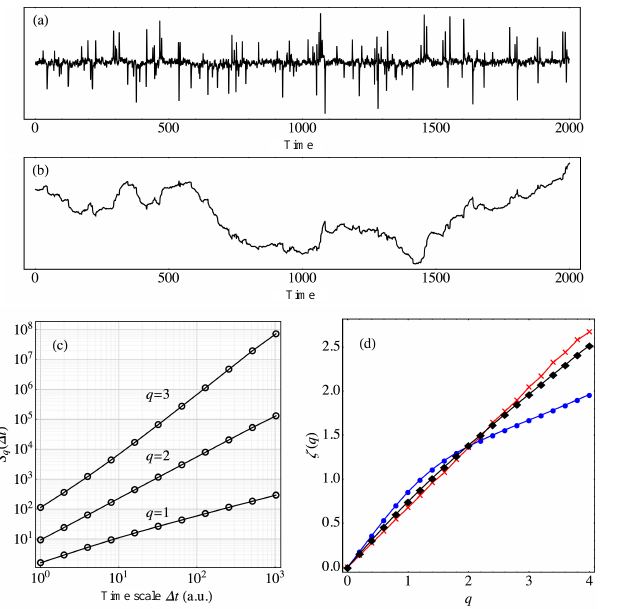
Figure 5. (a) The increments of a jump-diffusion process shown in (b) . This is a non-Gaussian independent noise process. (b) A re- alisation of a jump-diffusion process, and the cumulative sum of the signal in (a) . This process is the sum of a Brownian motion and a Poisson jump process as described in Appendix B. The jump distribution is Gaussian with a standard deviation that is 10 times greater than the standard deviation of the increments of the Brown- ian motion. (c) S q ( (cid:49)t for q = 1 , 2 , 3 for the jump-diffusion process as computed from a large ensemble of realisations of the process. (d) Scaling function ζ ( q ) estimated from structure functions like those in (c) . The red line is estimated by computing the slope of the structure-function curves on the longest timescale ( (cid:49)t = 500). The blue curve is estimated from the slopes at the shortest timescale (( (cid:49)t = 1). The black curve by estimating the slope of the straight line drawn between the end points of the structure-function curves.